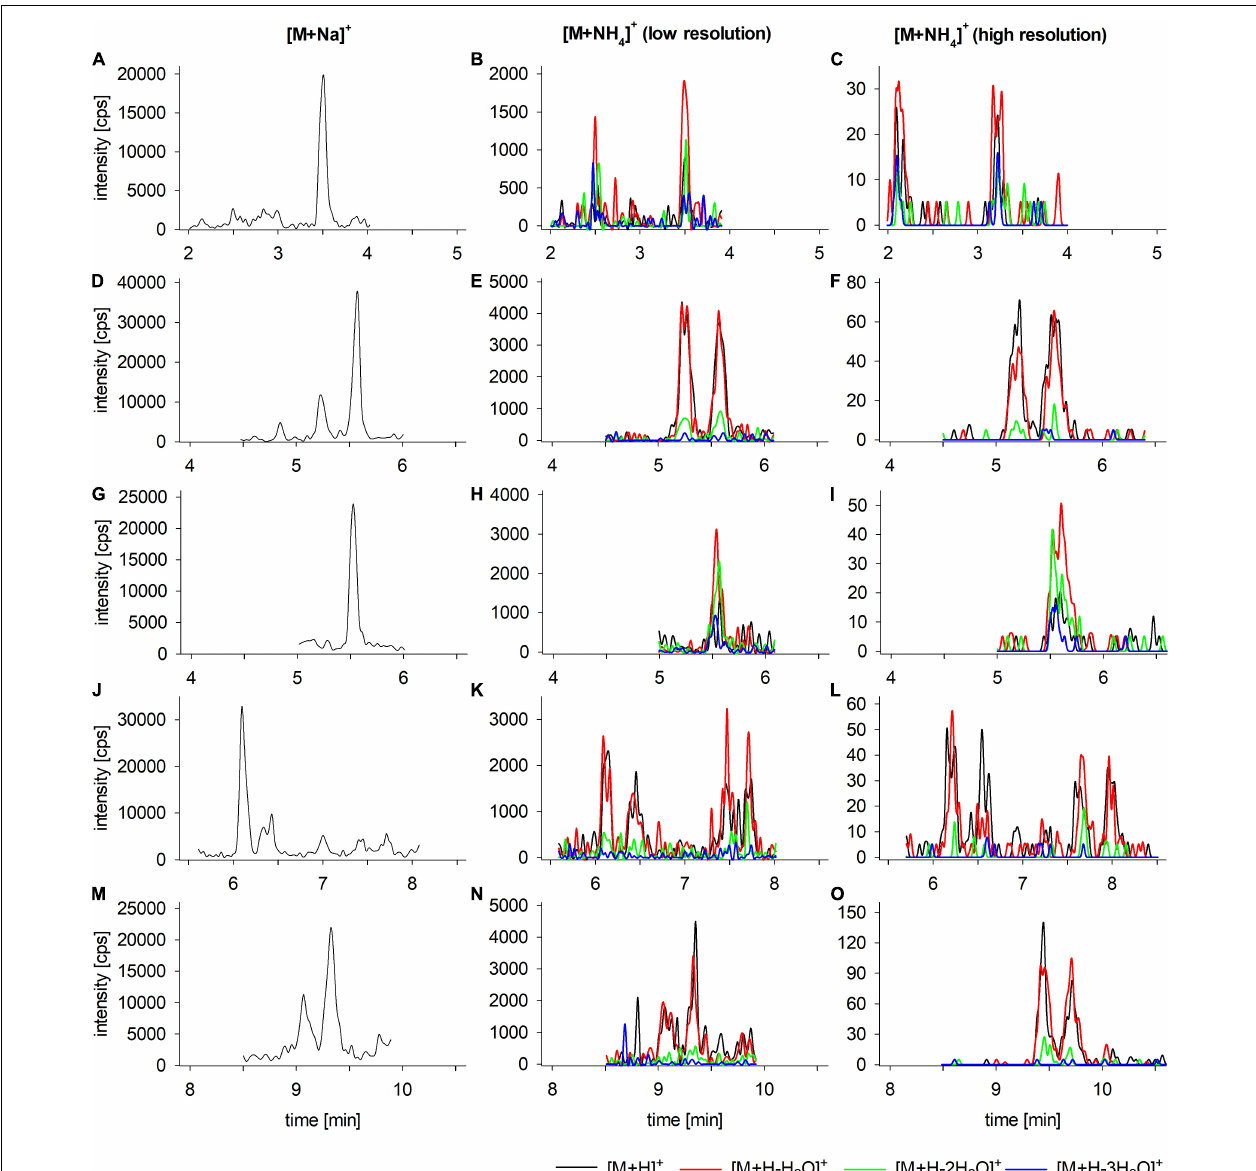
FIGURE 7 | Extracted Ion Chromatograms (EIC) of the LC-MS/MS analyses of the CTX-like positive sample #21 (toxicity determined by the N2a-MTT-assay, Section “Toxicity evaluation by in vitro Neuro-2a cytotoxicity MTT-assay”), the panels show the EIC of the respective m/z of (A–C) 2,3,51-trihydroxyCTX3C, (D–F) 2,3,-dihydroxyCTX3C, (G–I) 51-hydroxyCTX3C, (J–L) M- seco -CTX3C and 2-hydroxyCTX3C, and (M–O) CTX3C. Analyses were performed for the sodium adducts (left column) as well as the low-resolution (middle column) and high-resolution analyses (right column) of the fragments of the respective ammonium adducts. For ammonium adducts, fragments correspond to [M + H] + (black), [M + H-H 2 O] + (red), [M + H-2H 2 O] + (green), and [M + H-3H 2 O] + (blue) (for color the reader is referred to the online version of the manuscript), low and high-resolution analysis was performed with two different setups, leading to slightly different retention times, setup details are provided in Spielmeyer et al.